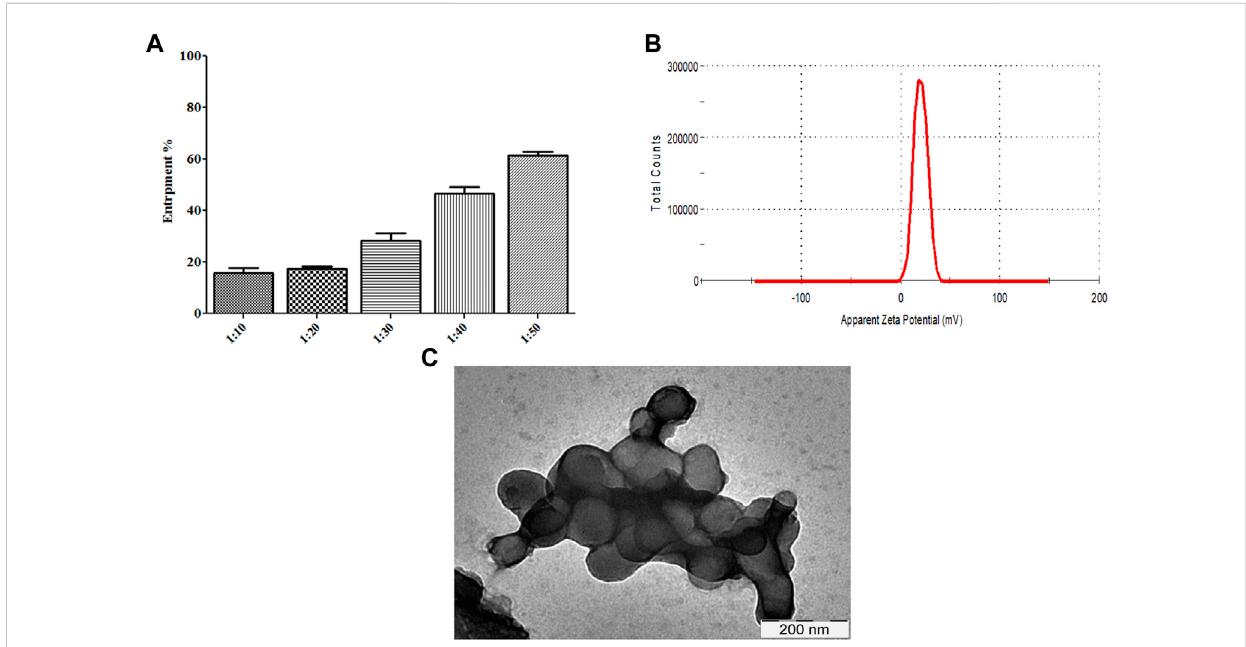
FIGURE 3 (A) EntrapmentofFu24HintoR Δ FNPs. (B) Zetapotential ofR Δ F-Fu24HcomplexstudiedusingDLS. (C) Transmission electronmicroscopyimageof R Δ F-Fu24H